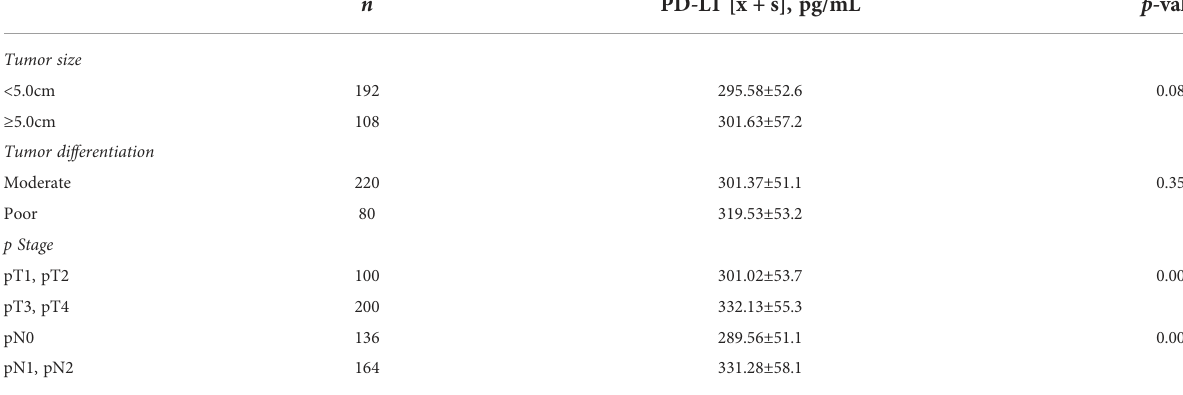
TABLE 2 Serum PD-L1 levels and clinicopathological